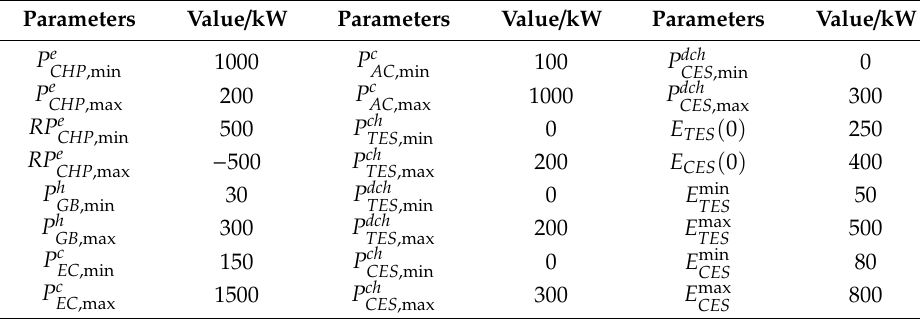
Table 2. Restriction conditions of relative devices.